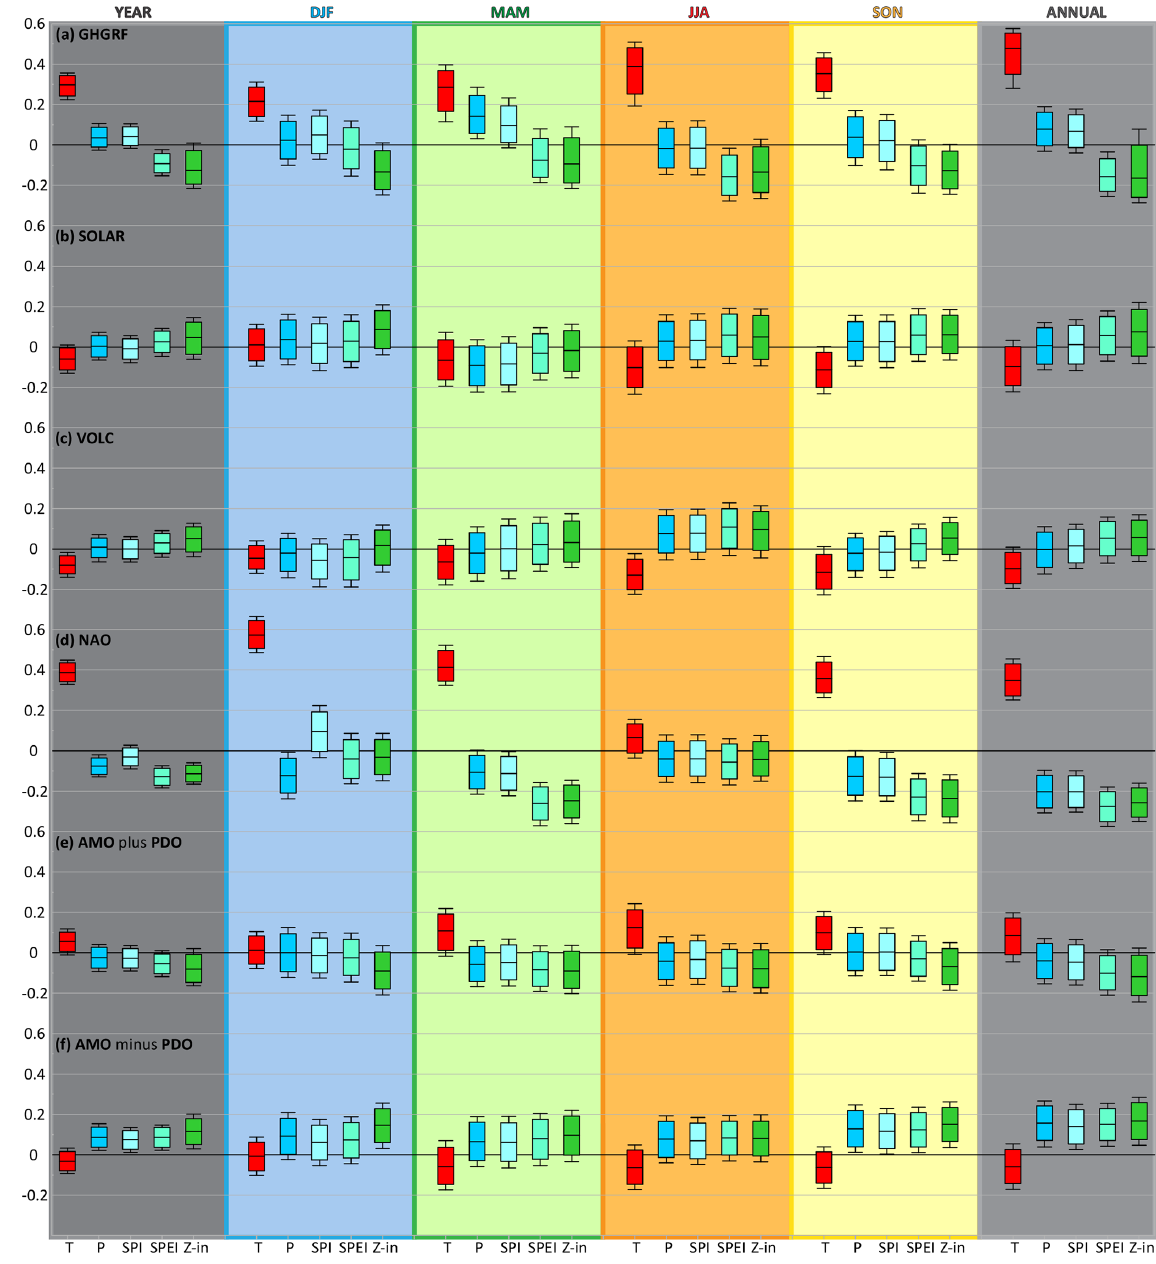
Figure 11. Standardized regression coefficients between individual target and explanatory variables as well as their 95% (box) and 99% (whiskers) confidence intervals. The results shown are for time series in seasonal time steps involving all seasons (YEAR), individual seasons analysed separately (DJF, MAM, JJA, SON), and annual averages